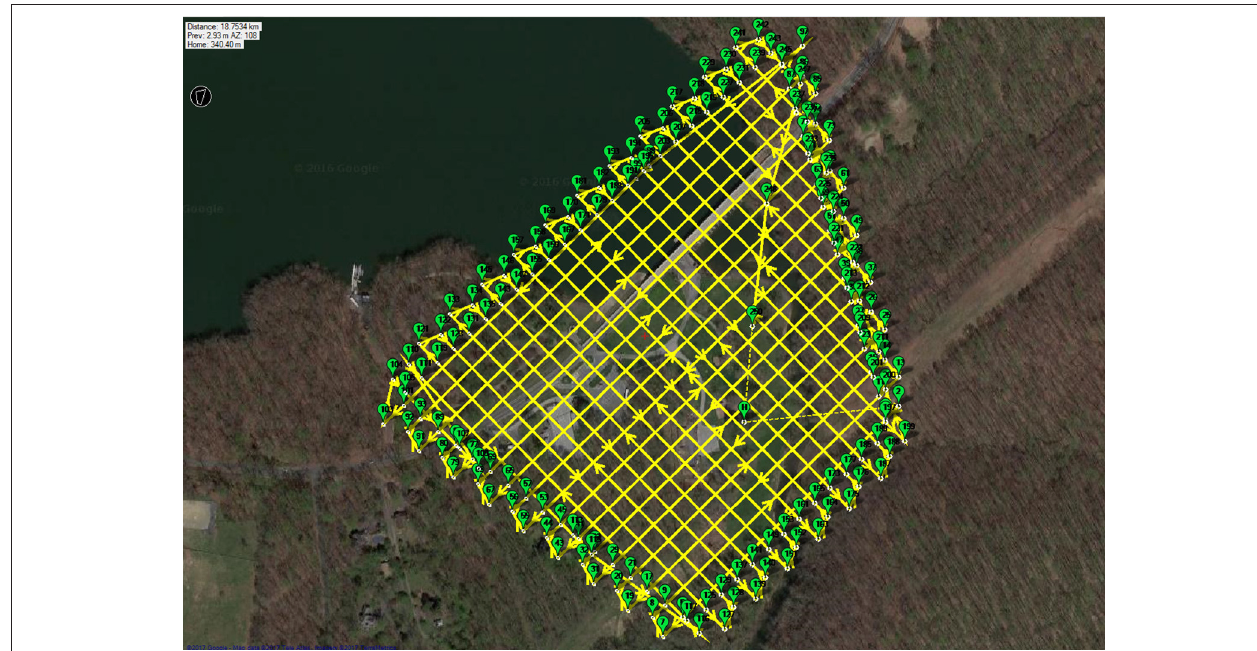
FIGURE 2 | Flight path for fixed wing UAV.